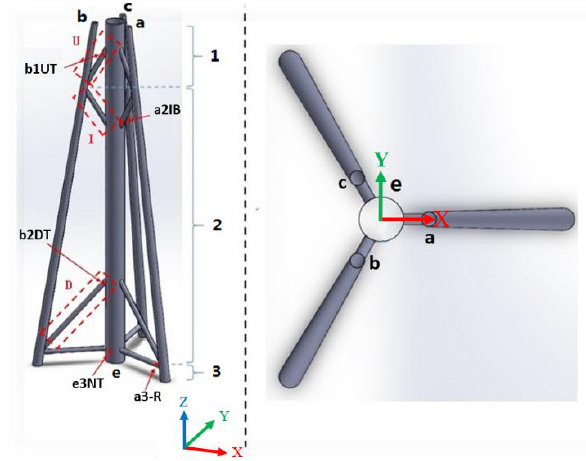
Figure A10. Four levels of abbreviations and examples used for J ‐ structure members and parts.